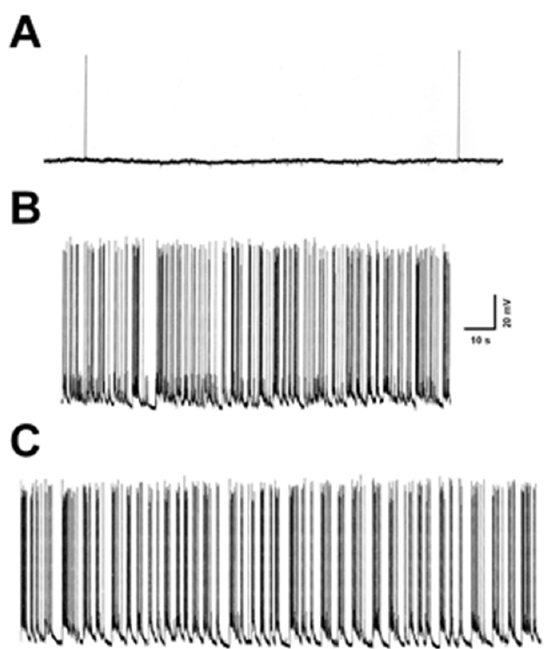
Figure 1. Electrophysiological monitoring of SE in hippocampal neurons. Culture dishes were incubated in control or low Mg 2+ solutions and neurons were patch clamped using the whole-cell current-clamp mode as described in Materials and Methods. Scale bar described in part B is applicable to all traces. ( A ) Representative recording of a neuron incubated in control solution. ( B ) Representative trace of a neuron incubated in low Mg 2+ solution for approximately 1 h. ( C ) Representative recording of a neuron incubated in low Mg 2+ solution for approximately 3 h.